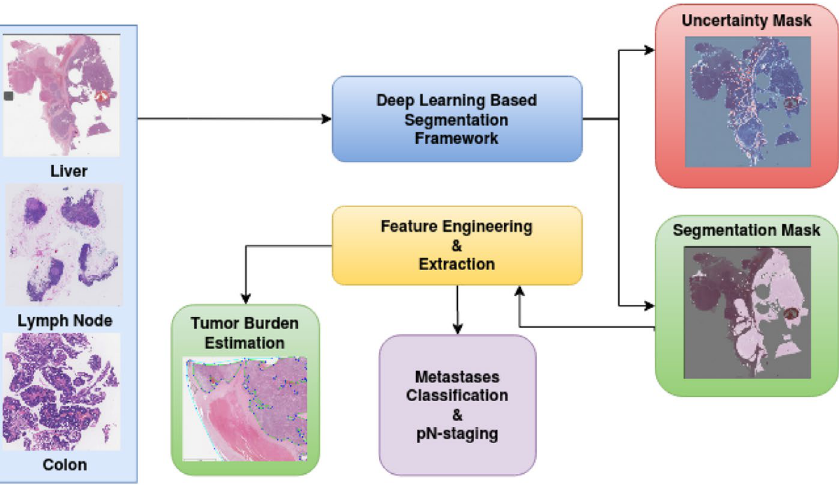
Figure 1. Deep learning based framework for segmentation and analysis of WSI images. Drawn using draw.io (draw.io).